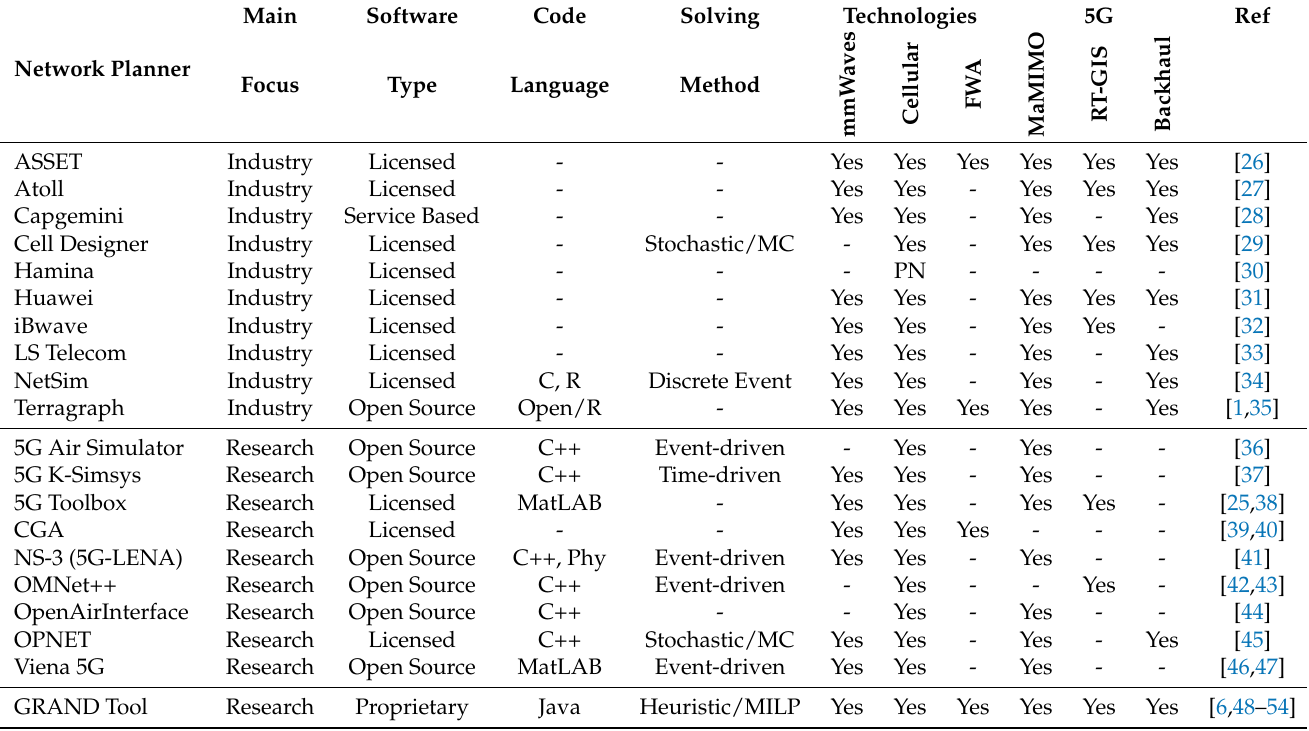
Table 1. Most relevant tools for 5G network modelling and